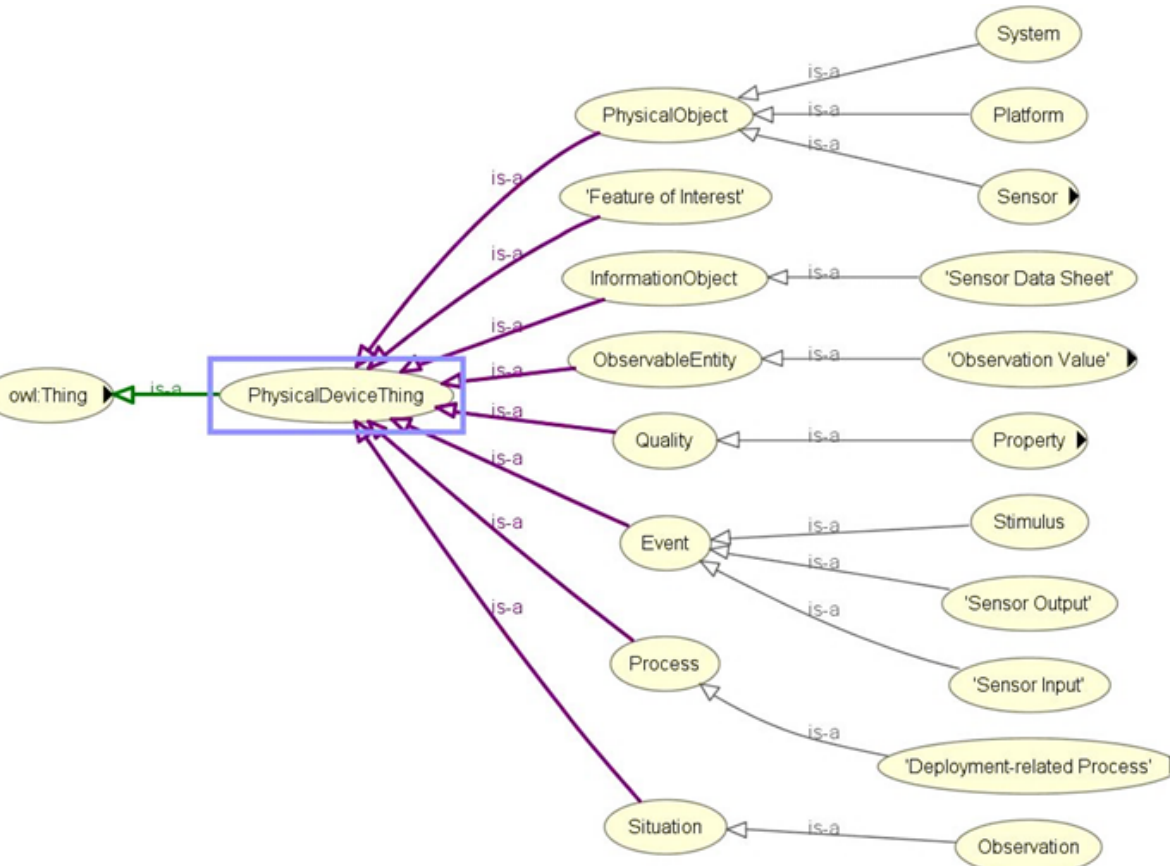
Figure 5. Asserted hierarchy for sensor-based data collection with